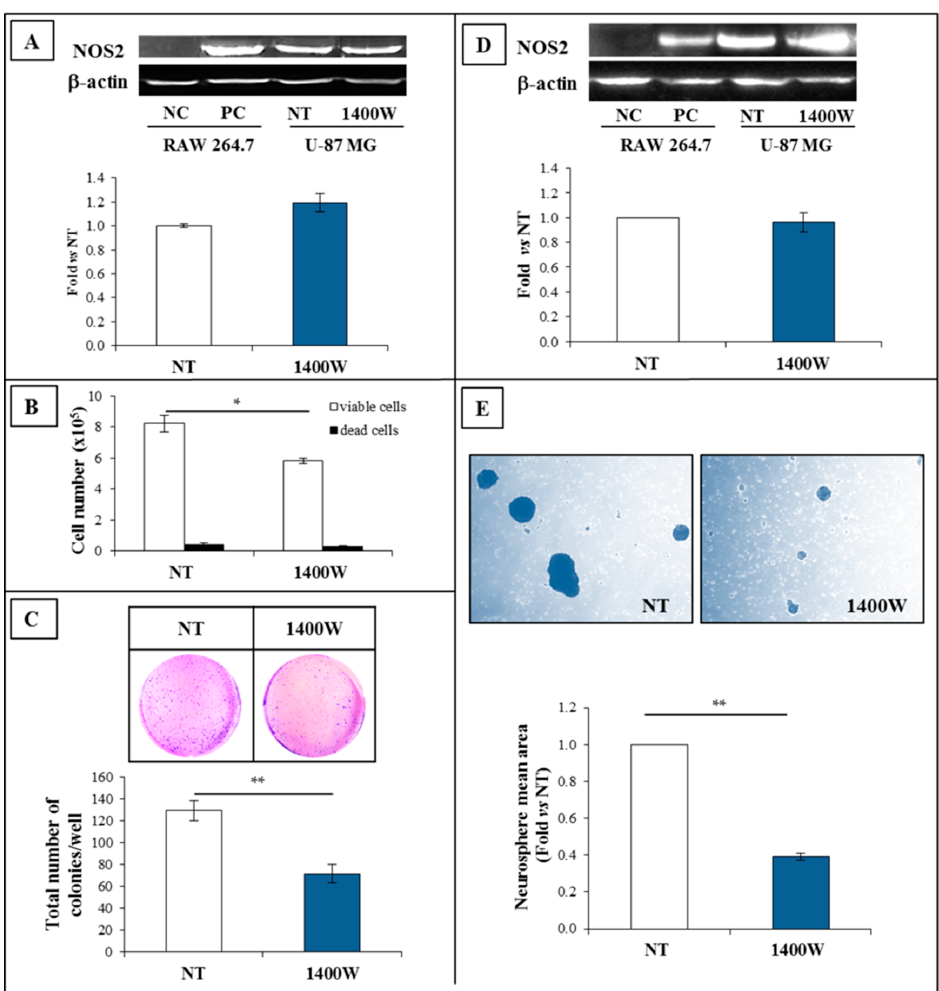
Figure 9. NOS2 expression in human glioblastoma primary cultures. ( A ) Representative Western blot of NOS2 and β -actin in GBM adherent glioma primary cells cultured in standard condition for 24 h. NC (negative control): Untreated RAW 264.7; PC (positive control): RAW 264.7 treated with LPS (1 μ g/mL) and IFN- γ (100 ng/mL) for 24 h. Results of quantification analysis of blots by densitometry expressed as fold vs. NT are reported in the histogram. The results from two independent experiments in duplicate are presented as mean ± SEM. ( B ) Effect of NOS2 inhibitor, 1400W (100 µ M) on GBM adherent glioma primary culture cell number (viable and dead cells) after 24 h of culture. The results from two independent experiments in duplicate are presented as mean ± SEM. For comparison between two means, Student’s unpaired t -test was used (* p < 0.05). ( C ) Representative microscopic images of the clonogenic assay of human adherent GBM primary culture not treated (NT) or treated daily with NOS2 activity inhibitor 1400W (100 µ M) for 20 days. Quantitative results of clonogenic assay are reported in the histogram and expressed as the total number of surviving colonies/well. Data represent the mean ± SEM of two independent experiments in duplicate. For comparison between two means, Student’s unpaired t-test was used (** p < 0.01). ( D ) Representative Western blot of NOS2 and β -actin in primary culture-generated neurospheres not treated (NT) or treated with 1400W (100 µ M), which was daily added to the culture for 20 days. NC (negative control): Untreated RAW 264.7; PC (positive control): RAW 264.7 treated with LPS (1 µ g/mL) and IFN- γ (100 ng/mL) for 24 h. Results of quantification analysis of blots by densitometry, expressed as fold vs. NT are reported in the histogram. The results from three independent experiments are presented as mean ± SEM. For comparison between NT and 1400W conditions, Student’s unpaired t -test was used. ( E ) Representative phase contrast images (4 × magnification) of human GBM primary culture maintained in GSC-M condition (GSCs) to allow neurosphere generation in the absence (not treated, NT) or presence of 1400W (100 µ M), added daily for 20 days. Quantification analysis of neurosphere mean area reported as fold vs. NT is shown in the histogram and expressed as the mean ± SEM of two independent experiments in duplicate. For comparison between two means, Student’s unpaired t -test was used (** p <